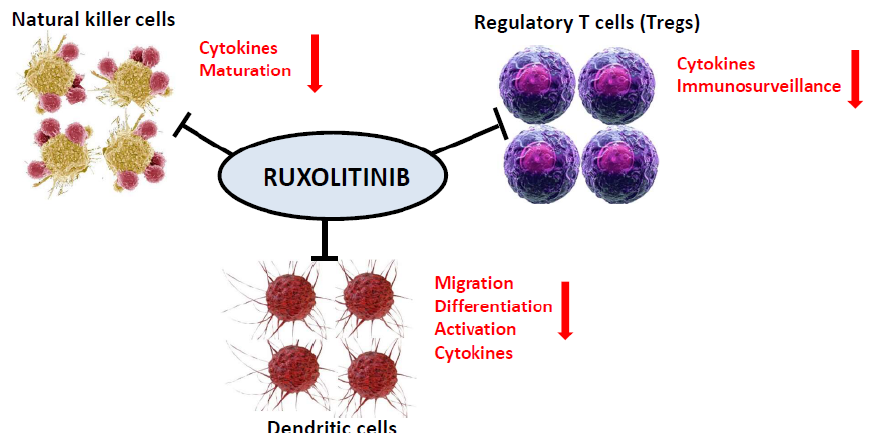
Figure 1. Ruxolitinib as a potent and selective inhibitor of both JAK1 and JAK2 protein kinases affects various components of both the innate and adaptive immune system such as dendritic cells, natural killer cells, T helper, and regulatory T cells.